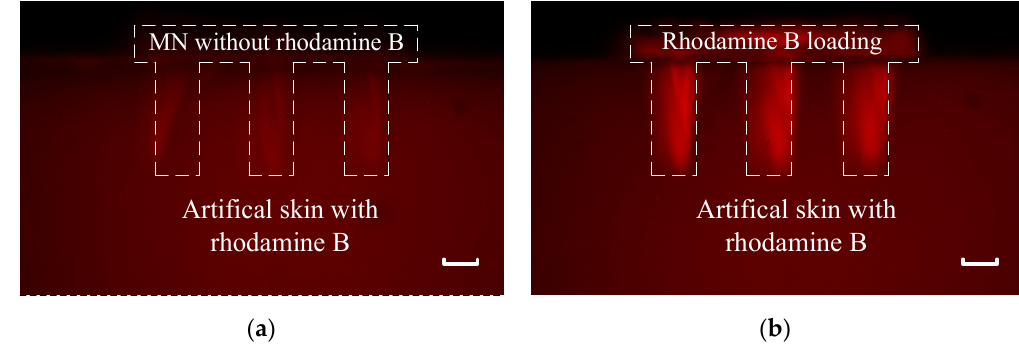
Figure 11. Fluorescence pictures of MNs without rhodamine B stuck into artificial skin with rhodamine B: ( a ) the moment MNs was stuck into artificial skin; ( b ) the MNs had been stuck into artificial skin for 30 min. The scale bar is 200 µm.